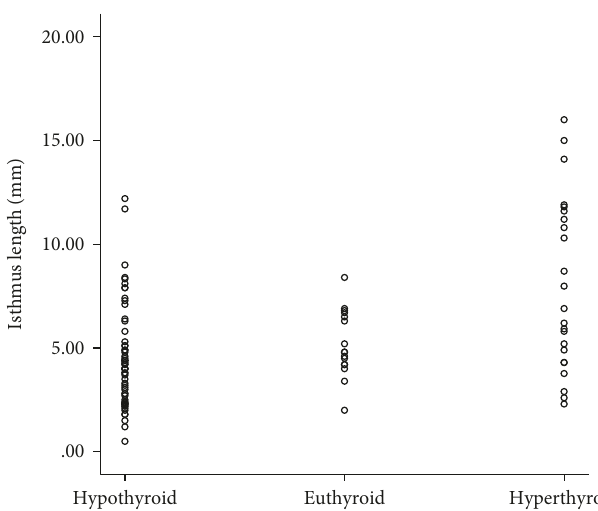
Figure 1: Distribution of isthmus length based on treatment results after radioactive iodine therapy.